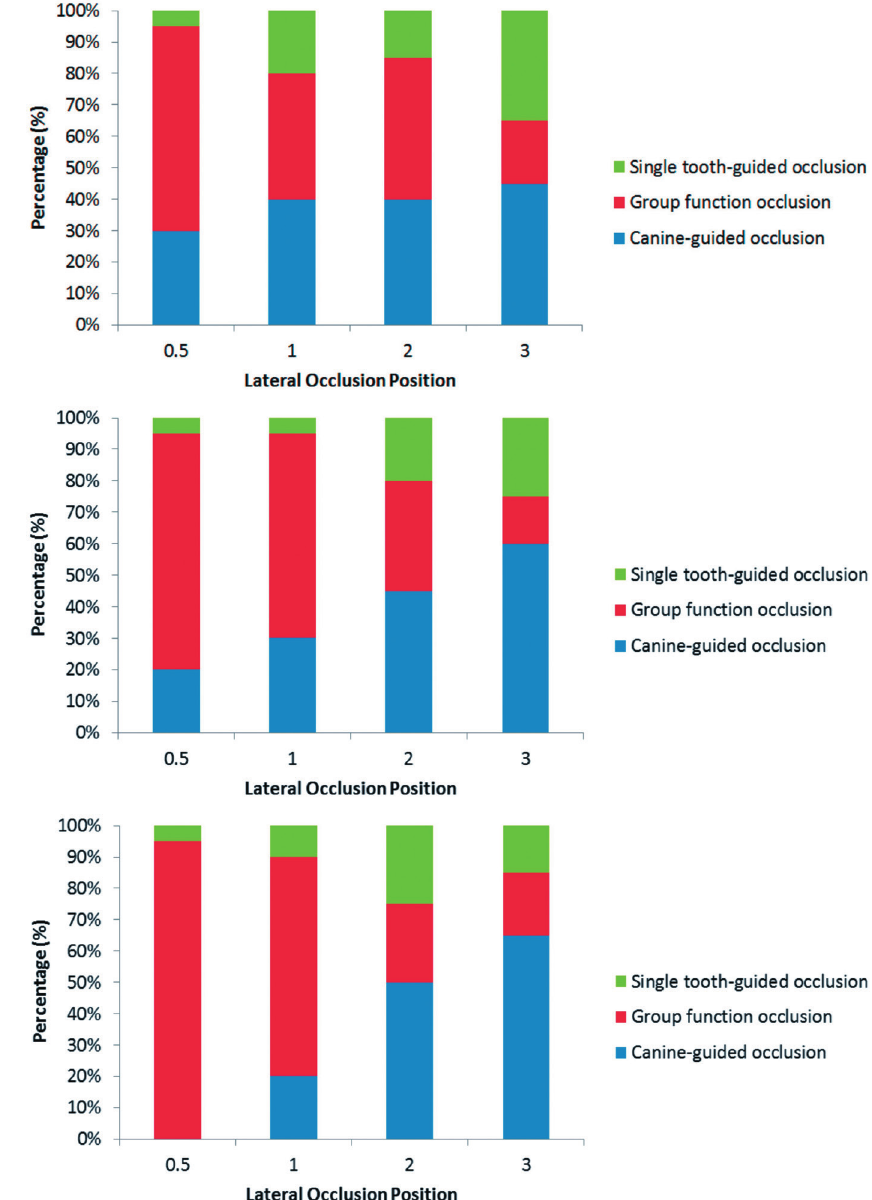
Figure 4- Proportion of each lateral occlusion scheme in each excursive position. (A) Pre-treatment models; (B) Conventional wax-up models; (C) Digital wax-up